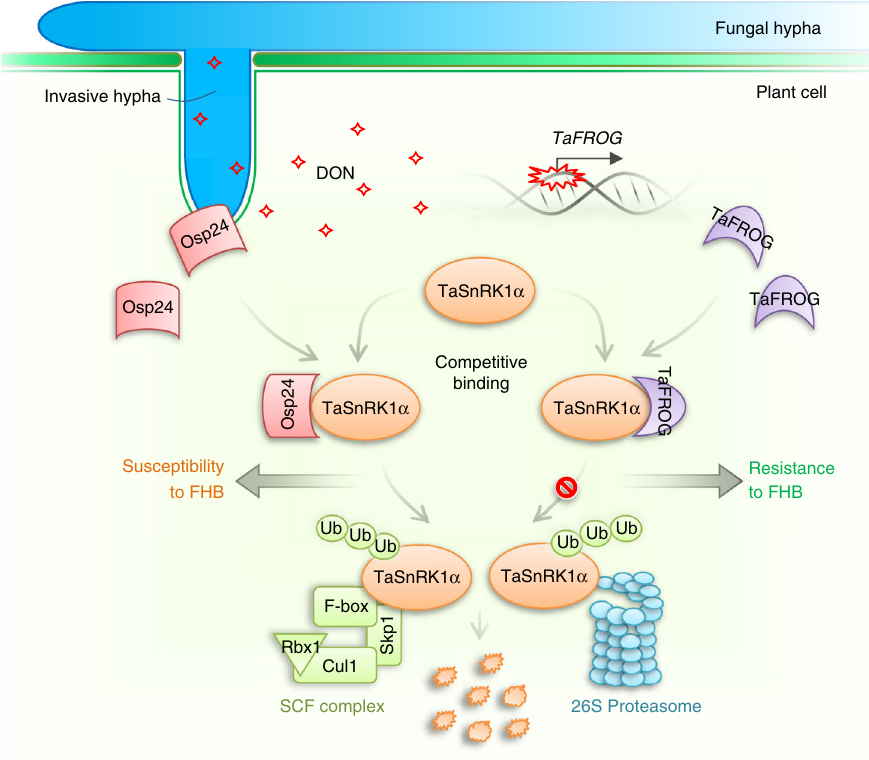
Fig. 5 A schematic summary of the roles of two orphan proteins from wheat and Fusarium graminearum during fungal – plant interactions. The cytoplasmic effector Osp24 secreted by invasive hyphae that develop in infected wheat tissues are translocated into plant cells. It interacts with TaSnRK1 α , a protein kinase activated by DON and important for resistance against F. graminearum in wheat. The association of Osp24 with TaSnRK1 α stimulates its degradation by the SCF ubiquitin ligase complex and 26S proteasome in infected plant cells, resulting in increased susceptibility to Fusarium head blight (FHB). However, DON produced by the fungal pathogen during infection induces the expression of TaFROG in wheat heads. TaFROG, a Pooideae -speci fi c orphan protein, competes with Osp24 for binding with TaSnRK1 α and increases its stability. Protection by TaFROG from proteasome degradation and activation by DON enhance the functions of TaSnRK1 α in regulating defense responses against F. graminearum